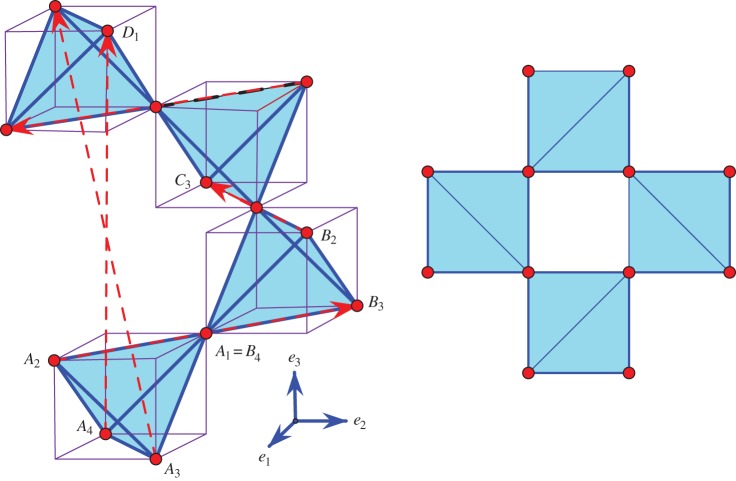
A representation of β-cristobalite, with highlighted oxygen tetrahedra and cubes traced around them for suggestive purposes. On the right: a view from above. (Online version in colour.)